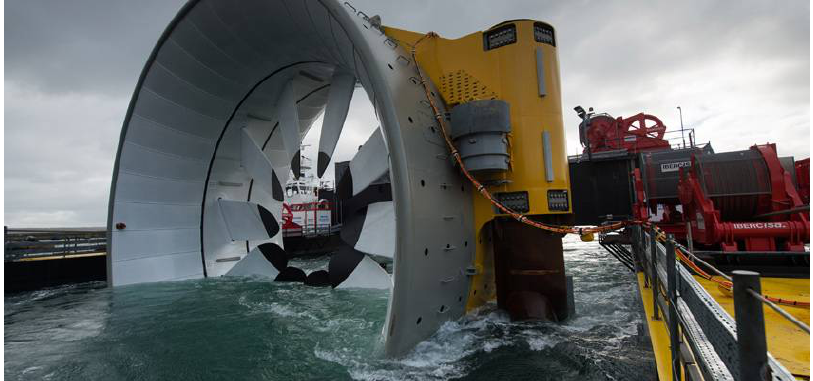
Figure 1. OpenHydro/Naval Energies direct-drive tidal stream turbine [4].